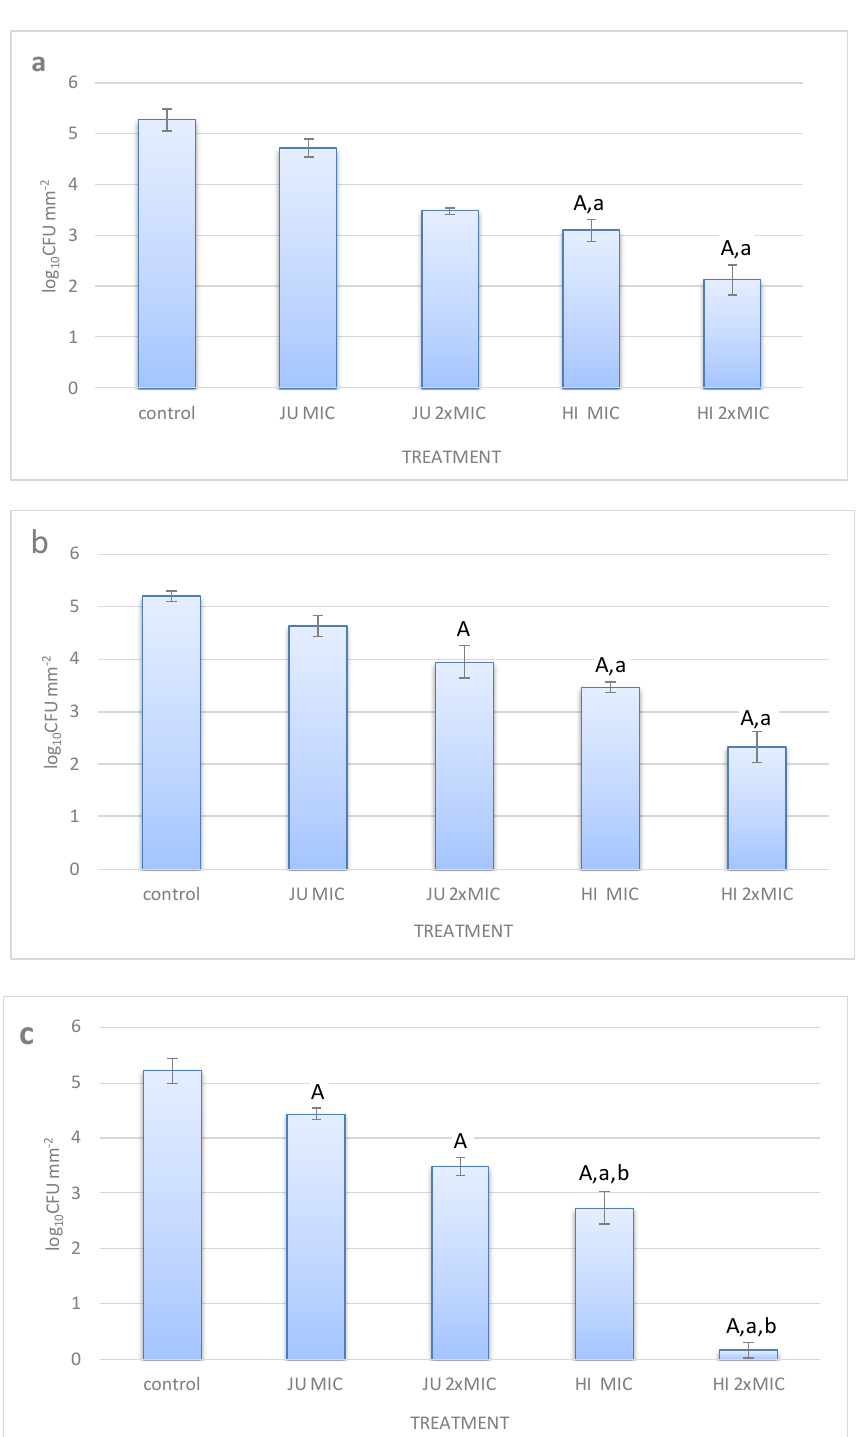
Figure 3. Effect of the MIC and 2 × MIC in mg mL −1 of J. communis and H. italicum EOs on the degradation of biofilms of M. avium ( a ), M. intracellulare ( b ), and M. gordonae ( c ) formed on stainless steel (AISI316) discs. Untreated mycobacterial cells served as controls. MIC—minimum inhibitory concentration; CFU—colony forming unit; JU— Juniperus communis ; HI— Helichrysum italicum . The experiment was repeated three times in duplicate and the mean ± SD is shown. Mean values marked with an uppercase letter A were significantly different compared to the control group. Mean values marked with lowercase letter a represent significant differences within different groups of EOs ( p < 0.05).